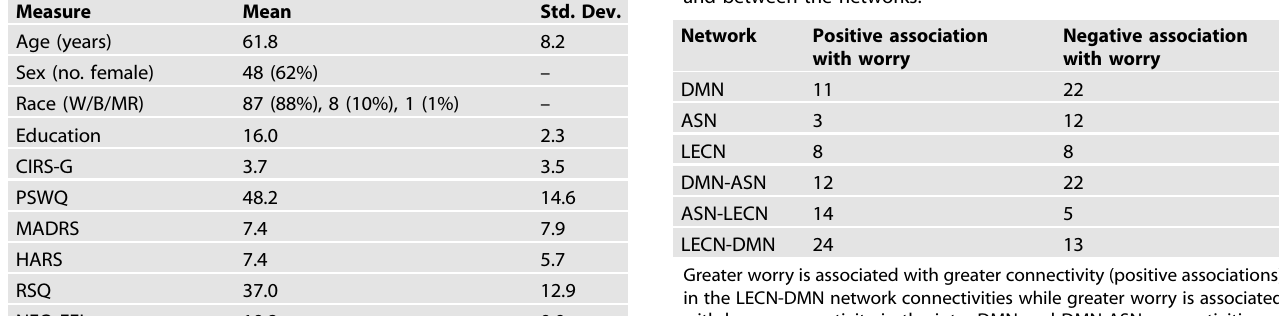
Table 1. Summary of participant demographics ( n =